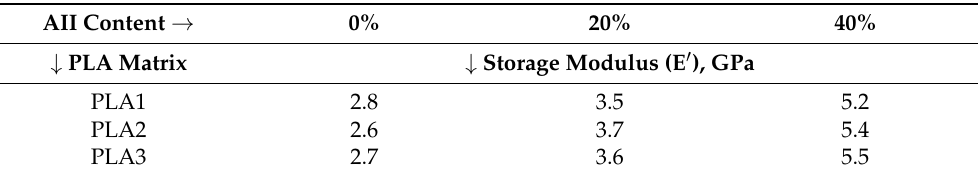
Figure 12. ( a , b ). Dependencies of ( a ) E ′ (storage modulus) and ( b ) E ″ (loss modulus) vs. temperature: neat PLAs compared with PLA − AII composites. Table 4. Effects of AII addition on the values of storage modulus (E ′ ) at the temperature of 60 °C for different PLA matrices.